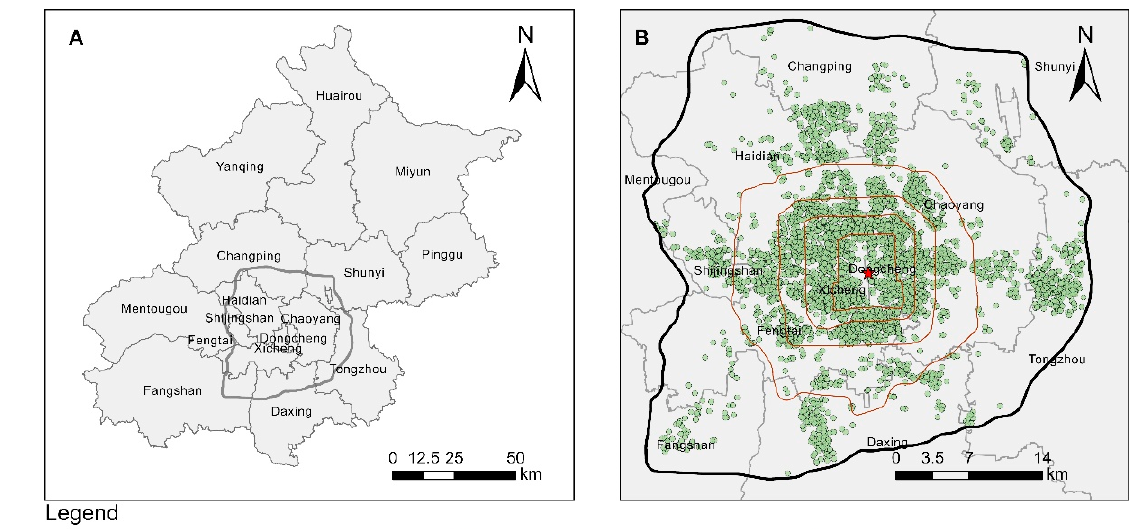
Figure 1. The Sixth Ring Road area and housing units in Beijing. Subplot ( A ): the location of study area. The red lines from the inside to the outside in subplot ( B ) are the Second to Fifth Ring Roads.